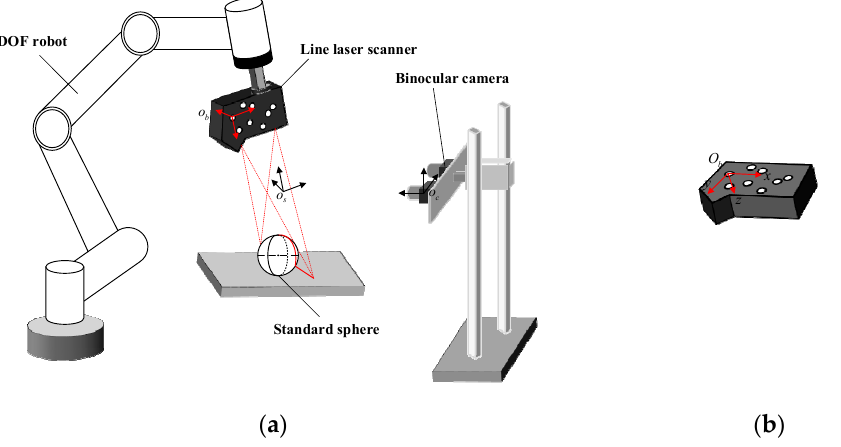
Figure 1. ( a ) System composition and structure diagram. ( b ) The markers and the marker coordinate system.